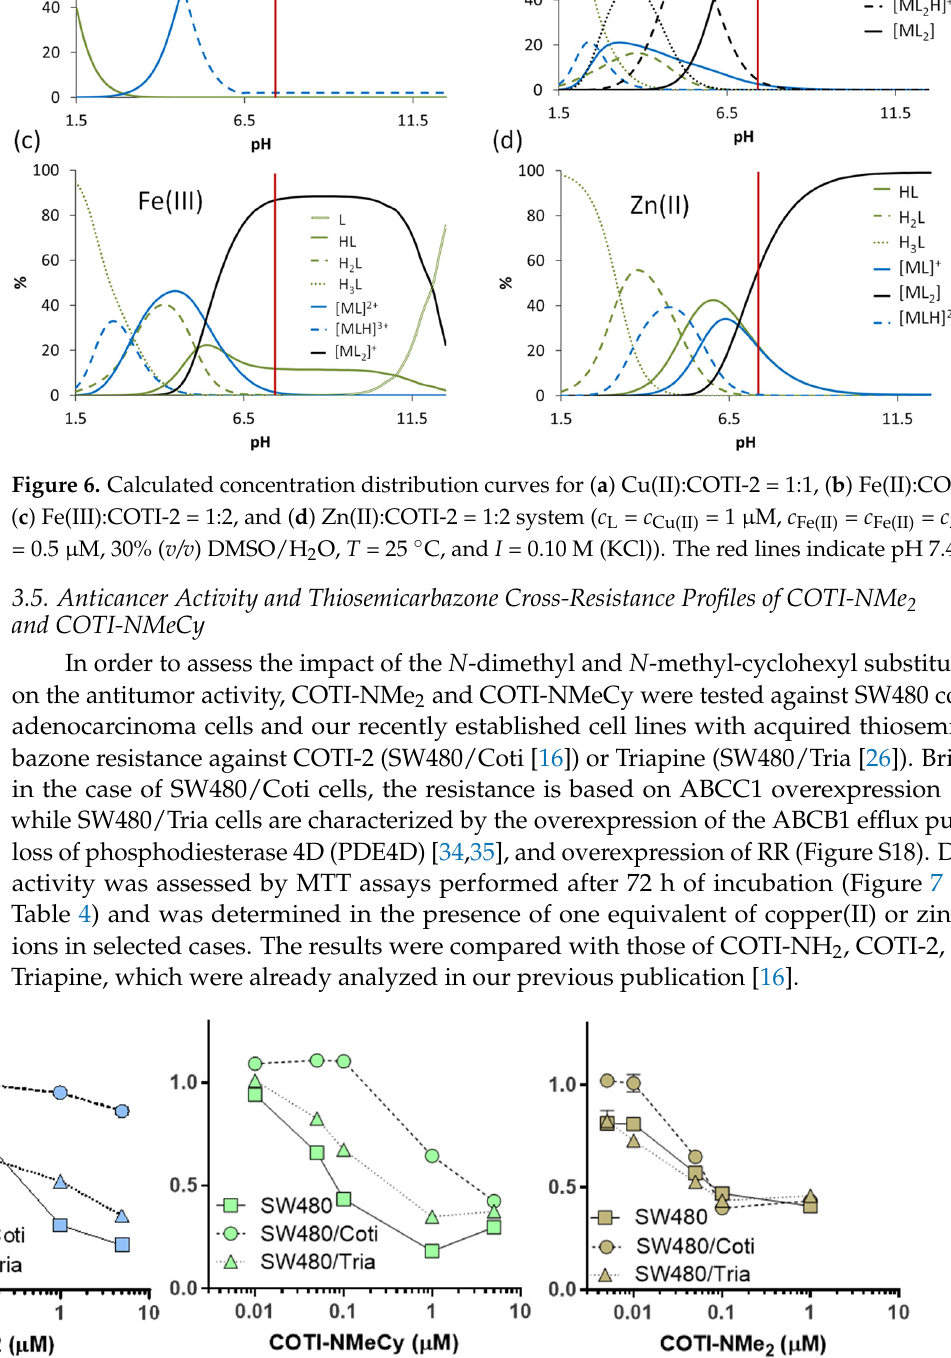
Figure 7. Fold viability plotted against the drug concentration to assay the resistance of SW480/Tria and SW480/Coti cells against COTI-NMeCy, COTI-NMe 2 , and COTI-2. The anticancer activity of the drugs was tested by MTT viability assay after 72 h of drug incubation in SW480 cells vs. the resistant sublines. The mean ± standard deviation (SD) was derived from triplicates of one representative experiment out of three. Table 4. Anticancer activity (IC 50 values after 72 h) of the indicated TSCs in SW480 cells, as well as the TSC-resistant SW480/Coti and SW480/Tria subclones.